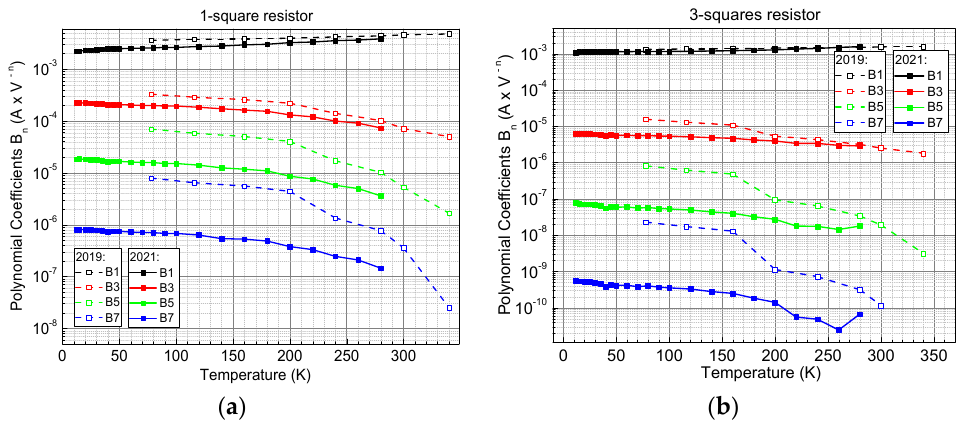
Figure 3. Cu-TiN x O y resistors non-linearity: ( a ) definition of the non-linearity parameter U 10 , which is the voltage that causes the differential resistance 10% change compared to its value at zero bias. In this particular example of I-V curve for 1-square long resistor measured at room temperature, U 10 = 3.191 V. ( b ) Resistors non-linearity parameter U 10 as a function of temperature measured 18 months apart.